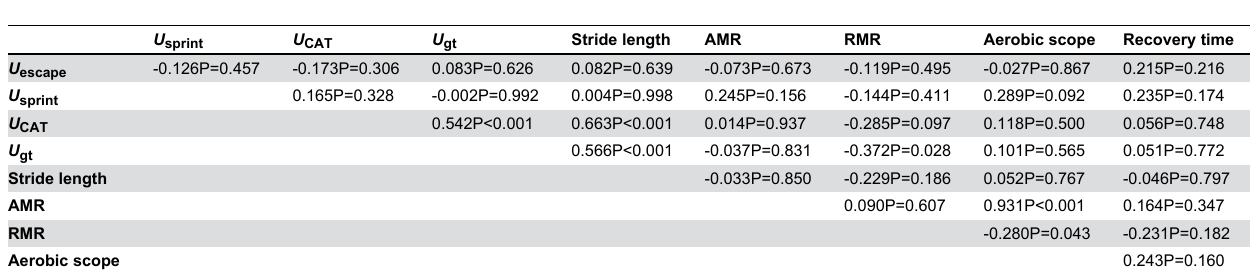
Table 2. Pearson correlations for the four swimming performance traits, stride length, metabolic rates and recovery time after